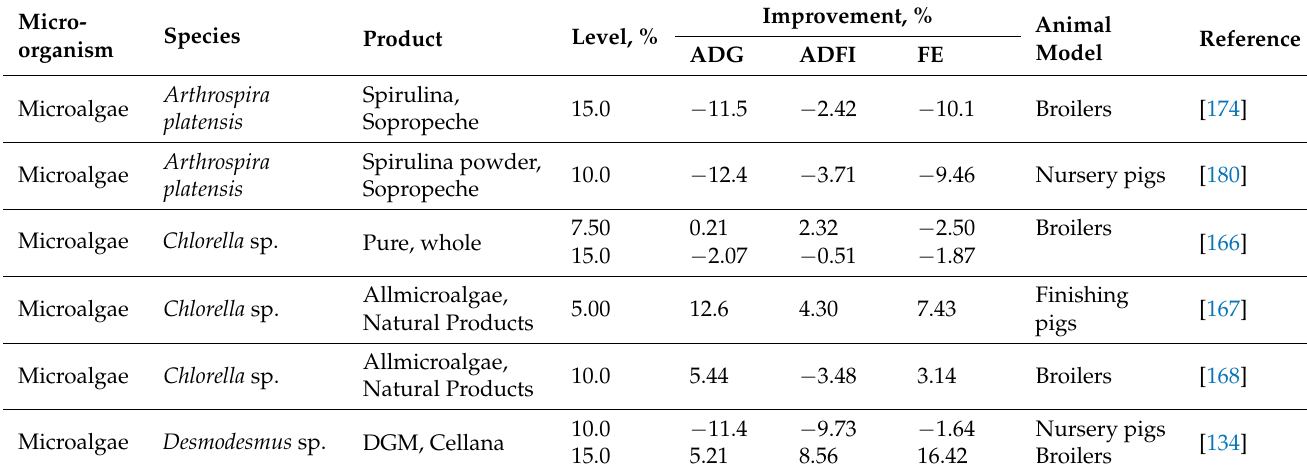
Table 8. Single-cell proteins from microalgae and their impacts on growth